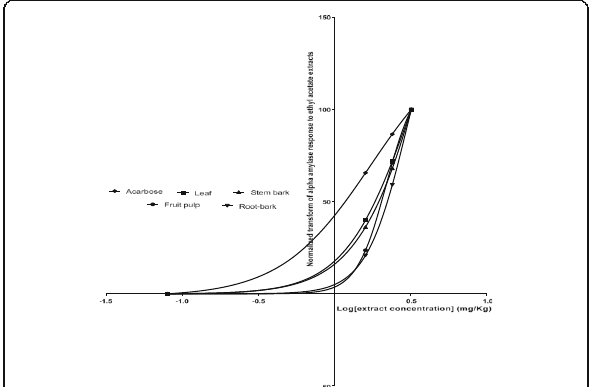
Fig. 5 Dose-response curve of α -amylase inhibition by ethyl acetate